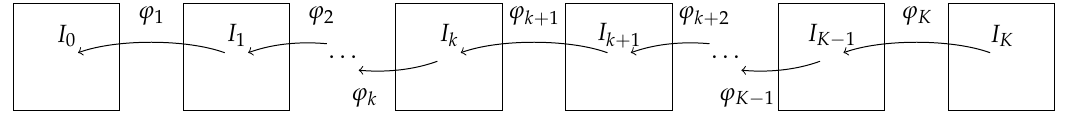
Figure 1. Illustration of the image path and the diffeomorphism path, where I 0 : = I temp and I K : = I tar are the given template and target